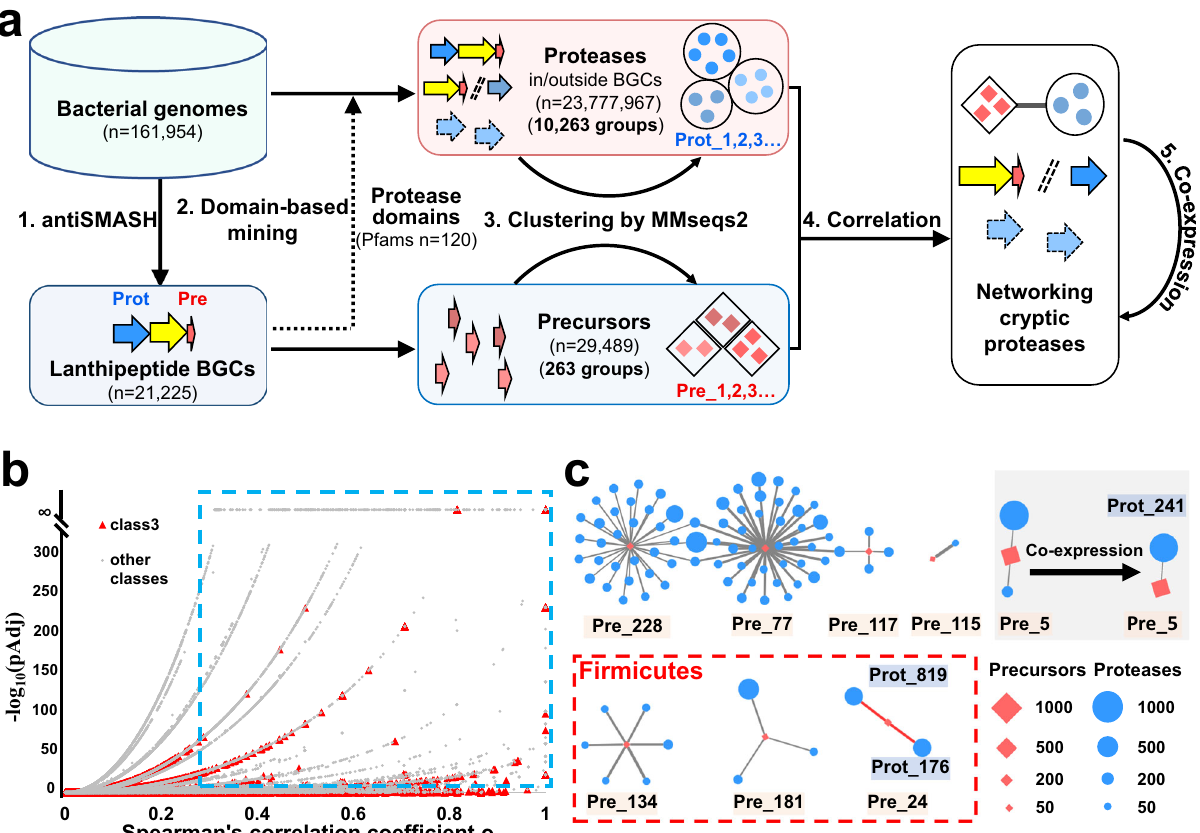
Fig. 1 Overview of the precursor-protease correlational networking for the discovery of hidden lanthipeptide proteases. a A genome-mining work fl ow for discovering potential hidden lanthipeptide proteases, including four steps: (1) antiSMASH 5.0 was used to analyze 161,954 bacterial genomes for identi fi cation of lanthipeptide BGCs and BGC-associated proteases; (2) a Pfam domain-based mining of proteases (either inside or outside of BGCs) was performed against entire bacterial genomes based on the 120 Pfams of BGC-associated proteases identi fi ed in step (1); (3) Proteases and precursors were clustered by sequence similarity using MMseqs2; (4) Correlation networks at the genomic level were constructed to link precursors and hidden proteases that are not encoded by the BGCs; and (5) Co-expression analysis was integrated to re fi ne the genomic-level correlation of interest. Pre: precursor peptides; Prot: proteases. b Volcano plot of 81,323 correlations at the genus level. The blue box encompasses 5209 signi fi cant correlations. Red triangles indicate correlations for class III lanthipeptides. P -values are calculated by one-sided t -test and adjusted by false-discovery rate. c Prioritized signi fi cant correlations ( ρ > 0.3, pAdj < 1E − 5, one-sided t -test, adjusted by false-discovery rate) for class III lanthipeptides from eight genera. Only correlations identi fi ed in at least ten genomes ( I ≥ 10) were prioritized. Red diamonds represent groups of precursors and blue circles represent groups of proteases. Shape sizes are proportional to the number of precursors or proteases identi fi ed in a group at the genus level. Edges connecting diamonds and circles indicate a signi fi cant correlation, with the increasing thickness of the edge representing the increasing strength of the correlation (Spearman ’ s ρ ). The 11 correlations in Firmicutes (indicated in red box) were formed between three groups of class III precursors (Pre_24, 134, and 181, totally 68 precursors) and 11 groups of peptidases. The remaining 80 correlations found in Actinobacteria were formed between fi ve groups of class III precursors (Pre_5, 77, 115, 117, and 228, totally 796 precursors) and 76 groups of proteases. Speci fi cally, Pre_5, the most abundant precursor group among the prioritized signi fi cant correlations, was strongly correlated with two groups of proteases, Prot_241 and Prot_1365. An integration of co-expression analysis reduced the two correlations to only one group, two, and one group(s) of proteases ( ρ > 0.3, pAdj < 1E − 5, I ≥ 10; Fig. 1c and Supplementary Table 2) at the genus level of Streptomyces , Paenibacillus , and Lentzea , respectively. None of the 888 proteases correlated to Pre_5, Pre_24, or Pre_115 had been characterized and only 19 of them are encoded by genes within the corresponding BGCs. Thus, this result exhibited the potential of our correlation network in identifying hidden